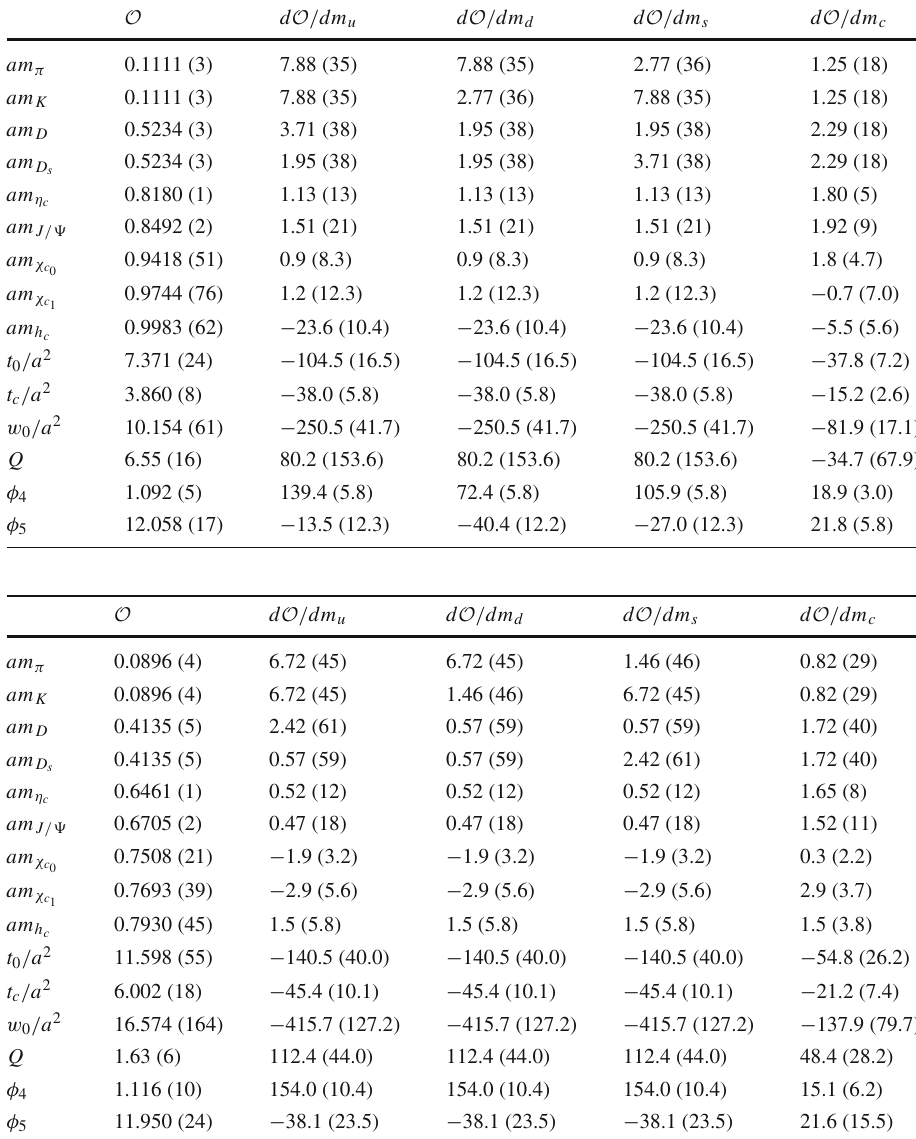
Table 10 Derivatives with respect to quark masses of pion/kaon, D - and D s -mesons and charmonium states η c , J /ψ , χ χ c 0 , c 1 and h c effective masses and flow observables on ensemble A2